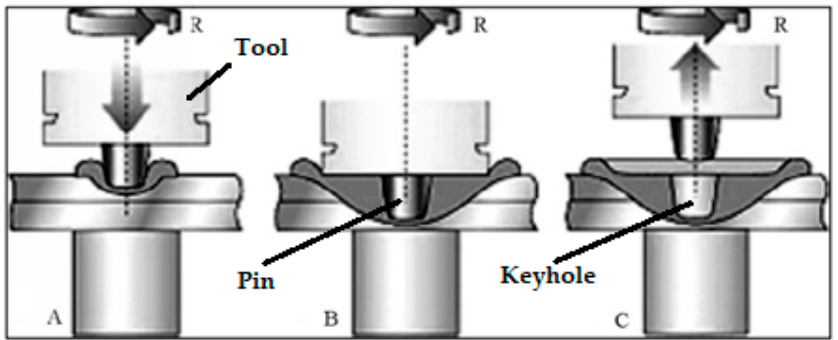
Figure 2. Schematic drawing of the friction stir spot welding application (A: Plunging, B: Stirring, C: Retracting) [8].